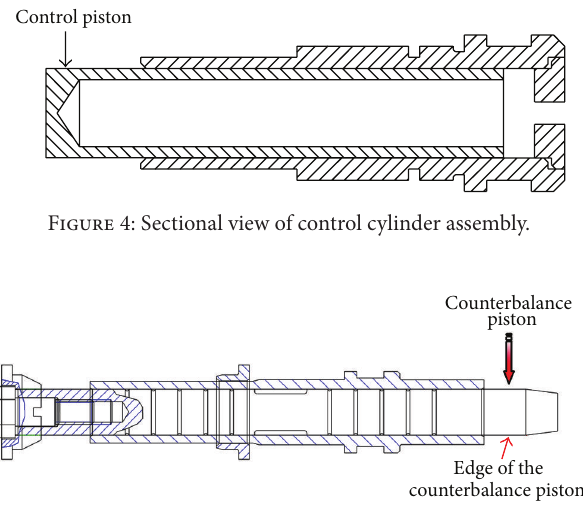
Figure 5: Sectional view of counterbalance assembly.